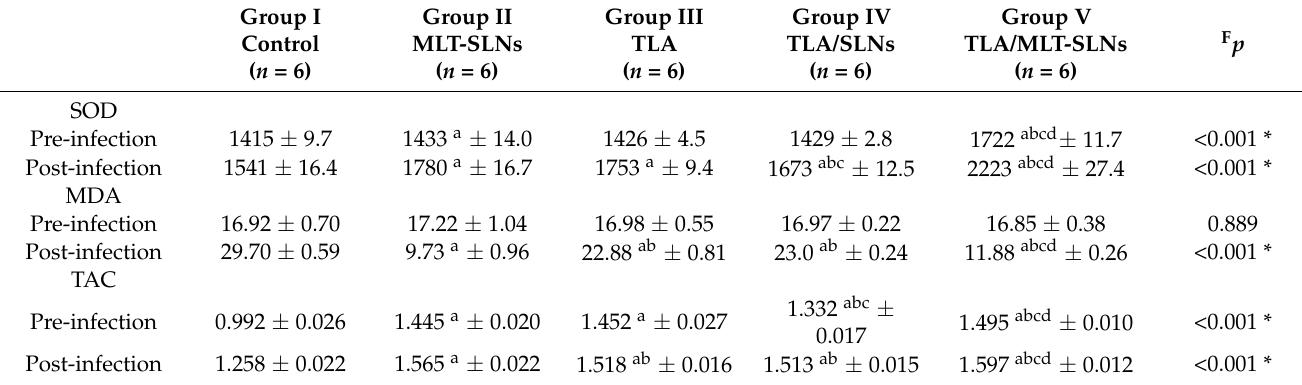
Figure 10. Pre-infection and post-infection splenic cell culture IFN- γ production among different studied groups. ( A ) INF- γ concentration (pg/mL) in the supernatant of splenic cell suspension two weeks after the last immunization dose (pre-infection). ( B ) INF- γ concentration (pg/mL) in the supernatant of splenic cell suspension four weeks following infection (post-infection). Data were expressed by using Mean ± SD. ***: Statistically significant at p ≤ 0.001. Group I: Control, Group II: MLT – SLNs, Group III: TLA, Group IV: TLA/ MLT plain SLNs, Group V: TLA/ MLT - SLNs. Table 1. Pre-infection and post-infection mean SOD level (U/g tissues), MDA level (nmol/mg) in brain homogenates, and TAC levels (mM/L) in sera of different studied